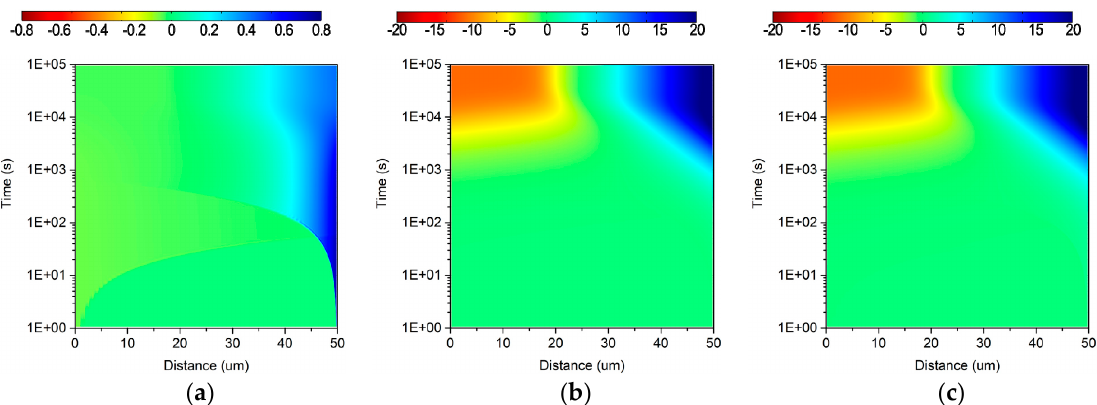
Figure 6. Space charge distribution at room temperature (=20 °C): (a) mobile charge density (C/m 3 ); (b) trapped charge density (C/m 3 ); (c) total charge density (C/m 3 ).